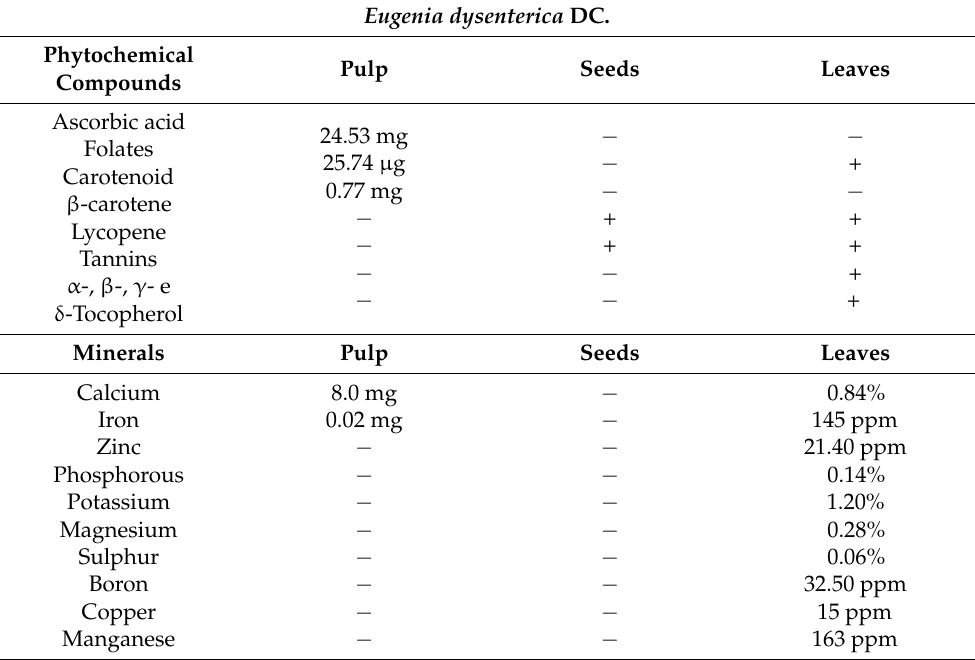
Table 2. Main phytochemical compounds and minerals (mg) in E. dysenterica DC. per 100 g of fruit, pulp and seeds